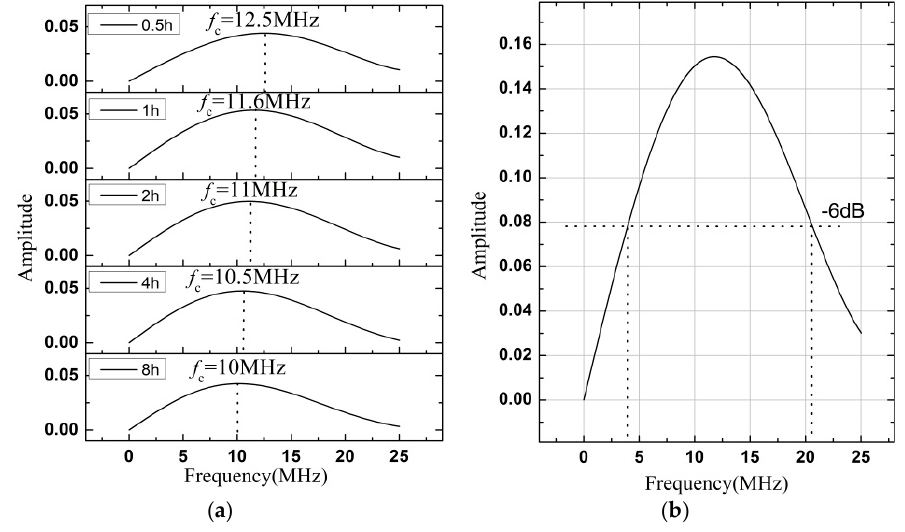
Figure 6. Frequency amplitude spectrum of the second compressive echoes measured after different holding times at 800 °C ( a ), and of the first compressive echo measured for the as ‐ received sample ( b ).